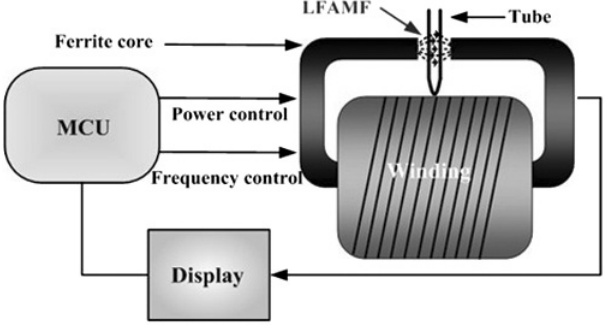
Fig. 1. Schematic diagram of LFAMF generator.